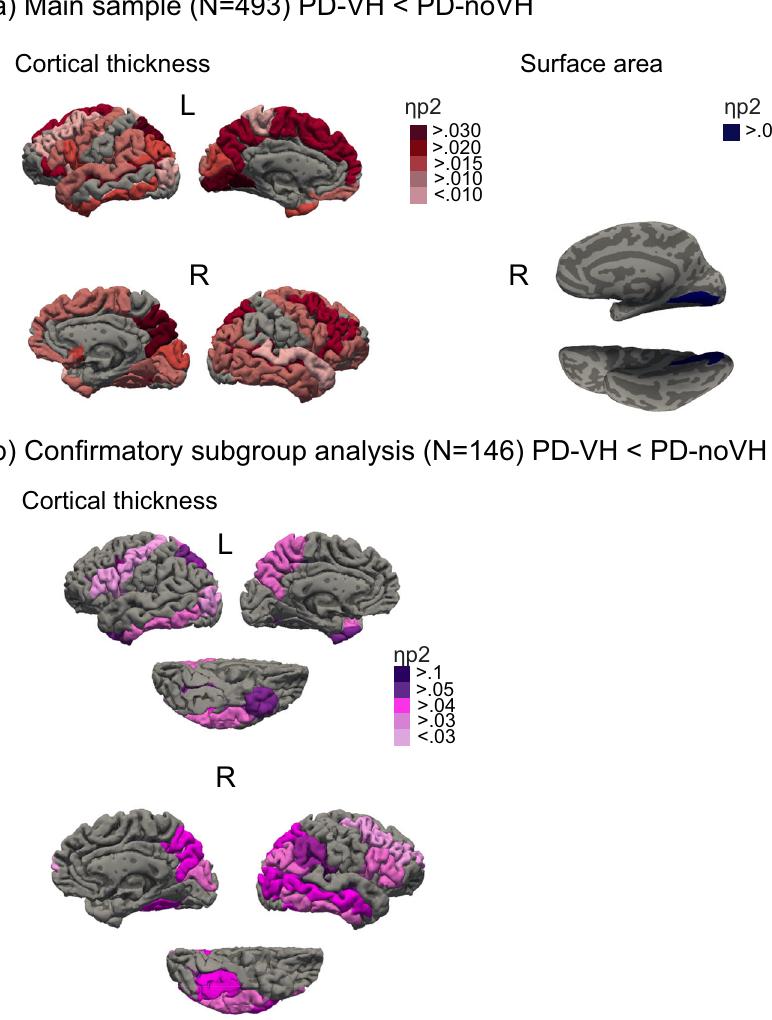
Fig. 1 Group differences for PD-VH (patients with hallucinations) vs. PD-noVH (without hallucinations). a The fi gure is a visual summary of the results for the multivariate between subjects (VH/noVH) ANCOVA, using age, gender and TIV as covariates. Shown are regions whereby PD-VH had decreased cortical thickness (right) and surface area (left). Widespread decreased thickness was found in PD-VH; the regions with the greatest effect size were occipitotemporal (occipitotemporal and occipital sulci, inf. temporal gyrus), parietal (precuneus, intraparietal sulcus) and frontal (superior and middle frontal gyri, inferior frontal gyrus) regions. Surface area was reduced in PD-VH in the right occipitotemporal gyrus/medial occipital cortex. b The fi gure is a visual summary of the results for the multivariate between subjects (VH/noVH) ANCOVA, using age, gender, TIV, LED, disease onset, UPDRS-III and MMSE as covariates for the replication cohort ( N = 146, NPI subsample) (for details see 2.3 and S4). Regions are colour coded by effect size (details in S3). Results were corrected for multiple comparisons (FDR) and pairwise comparisons (Bonferroni) (see “ Methods ” section). Individual statistical values for each region are provided in the Supplemental Information S3 in tables, one for each